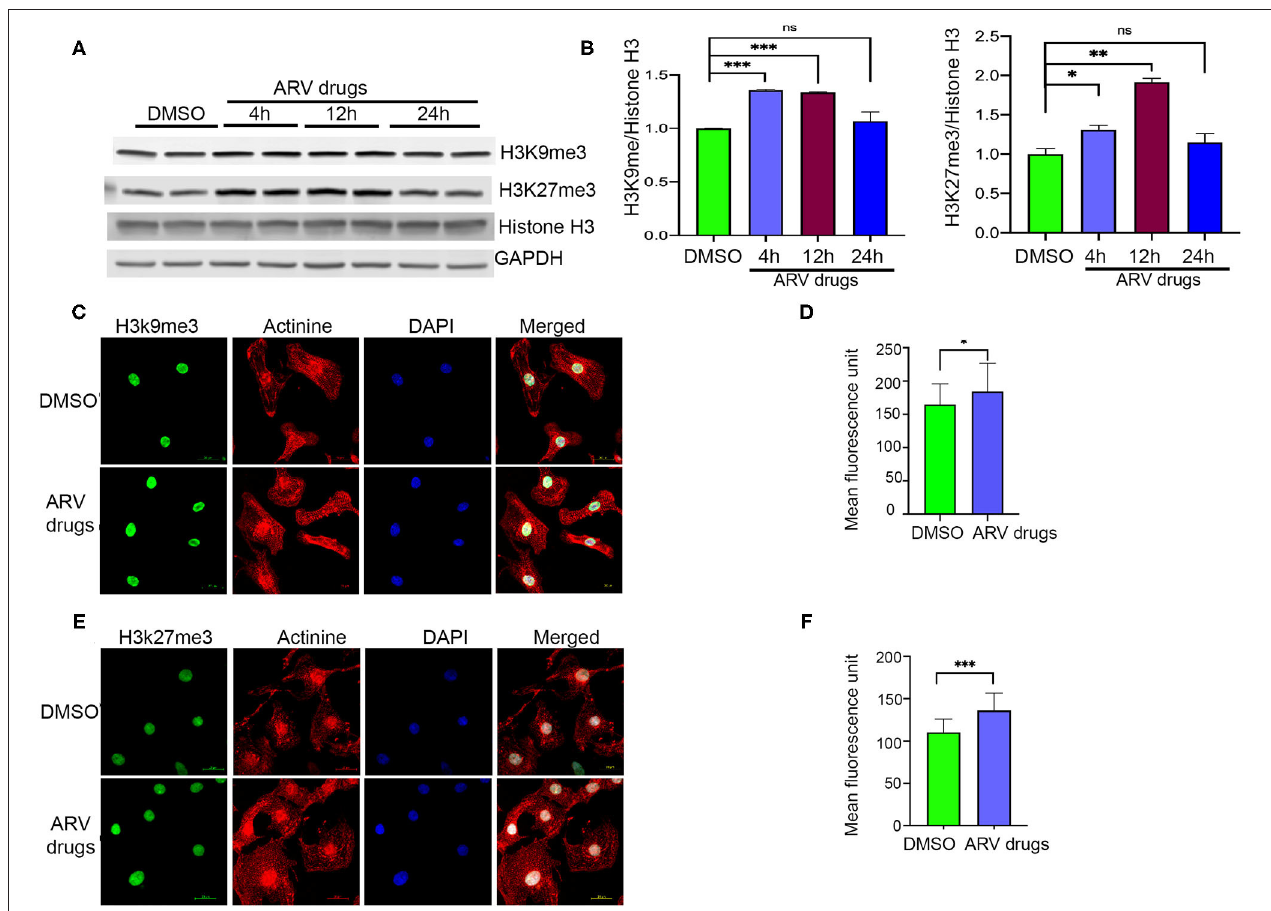
FIGURE 2 | ARV drugs treatment promotes repressive histone marks. (A,B) Western blot shows antiretroviral drug treatment increase the methylation of H3K27me3 and H3K9me3. NRVCs were treated with ARV drugs (5 µ M of Ritonavir, Abacavir, Atazanavir and Lamivudine) for 4, 12, and 24h and western blots were done with total protein lysate. Graph shows quantification of western blots (*** p < 0.001; ** p < 0.01, ns, not significant) (C) Representative images show immunofluorescence staining of NRVCs stained with H3K9me3 (green), actinin (red), and nucleus stained with DAPI (blue). Cells were treated with ARV drugs for 12h and fixed with 4% PFA. (D) Graph shows quantification of microscopic images ( n = 50 cells); (* p < 0.05). (E) Representative images show immunofluorescence staining of NRVCs stained with H3K27me3 (green), actinin (red), and nucleus stained with DAPI (blue). Cells were treated with ARV drugs for 12h and fixed with 4% PFA. (F) Graph shows quantification of microscopic images ( n = 50 cells); (*** p < 0.001).